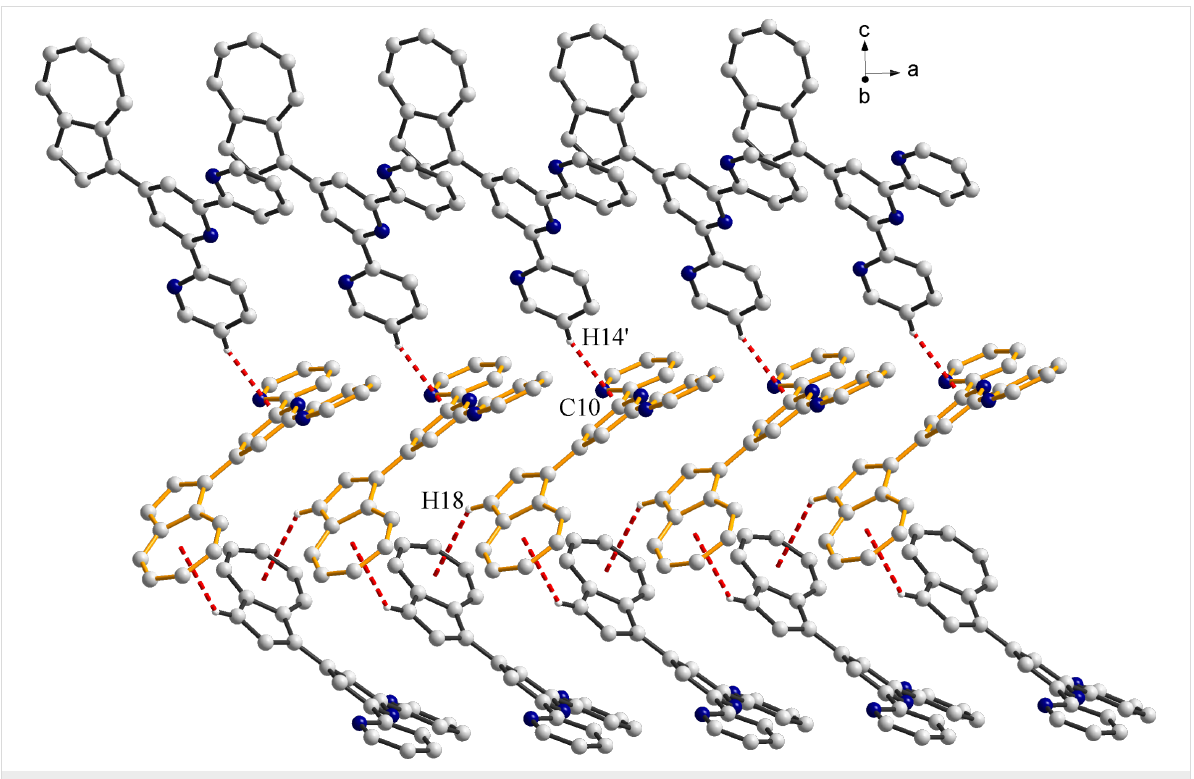
Figure 2: Packing diagram for 4a showing the π – π stacking and CH– π interactions between the pyridine rings and the azulenyl moieties. Only the hydrogen atoms involved in hydrogen bonding interactions are shown.